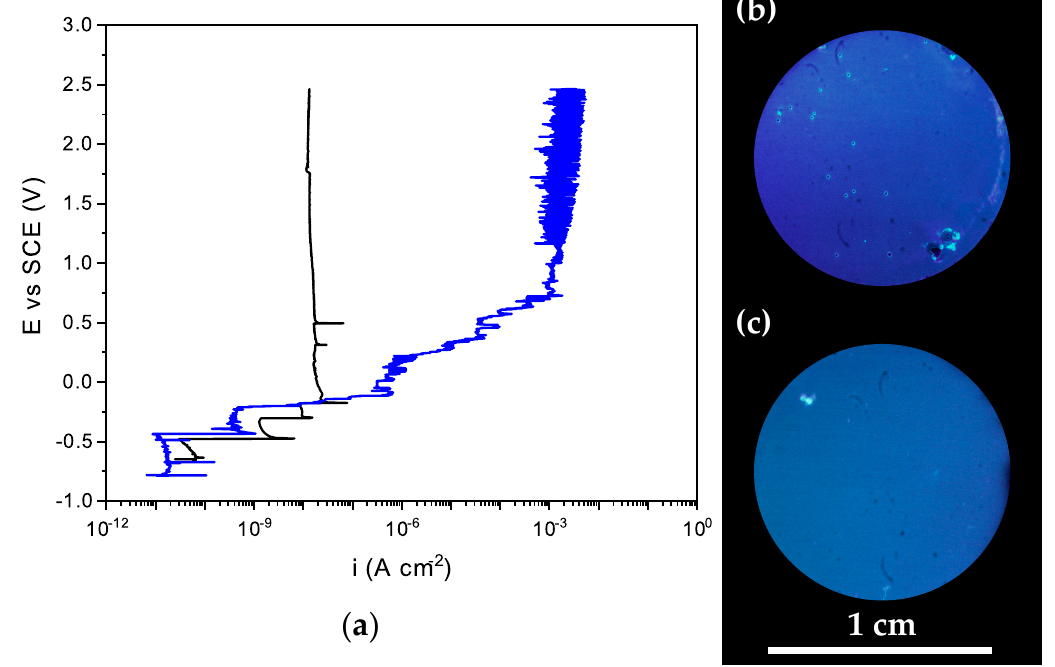
Figure 6. ( a ): Anodic polarization curves for AA2024 coated with copolymer with 6.1% (blue lines) and 13.4% ocytyloxy units (black lines) in naturally aerated near-neutral 0.6 M NaCl solution. Right: Optical microscope pictures (under 395 nm light irradiation) of samples coated with copolmyer containing 6.1% ( b ) and 13.4% octyloxy units ( c ) after polarizations